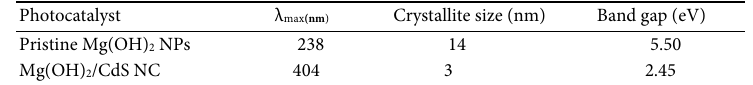
NPs and Mg(OH) /CdS 2 2